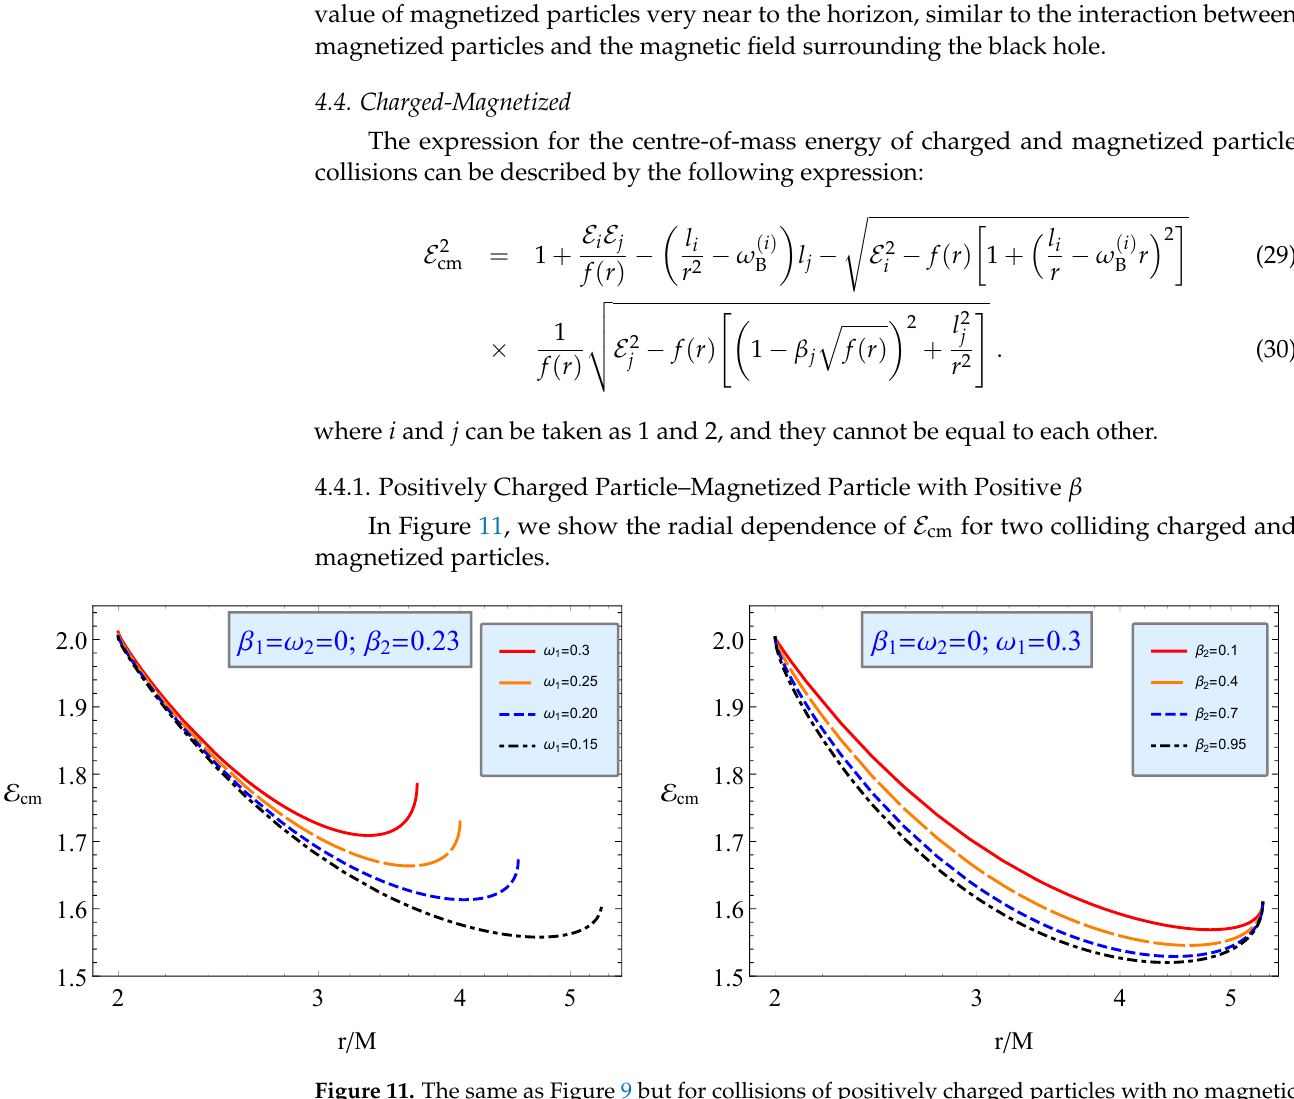
Figure 11. The same as Figure 9 but for collisions of positively charged particles with no magnetic dipole-positive magnetized particles with no